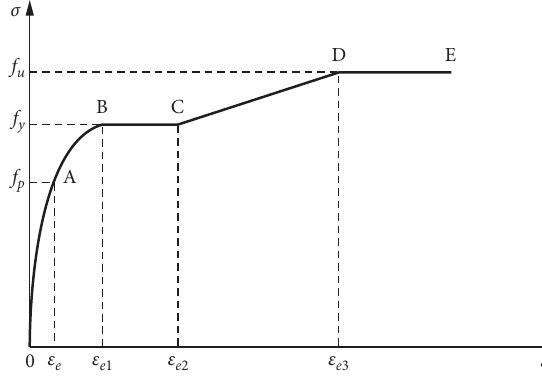
Figure 4: Stress and strain relationship of